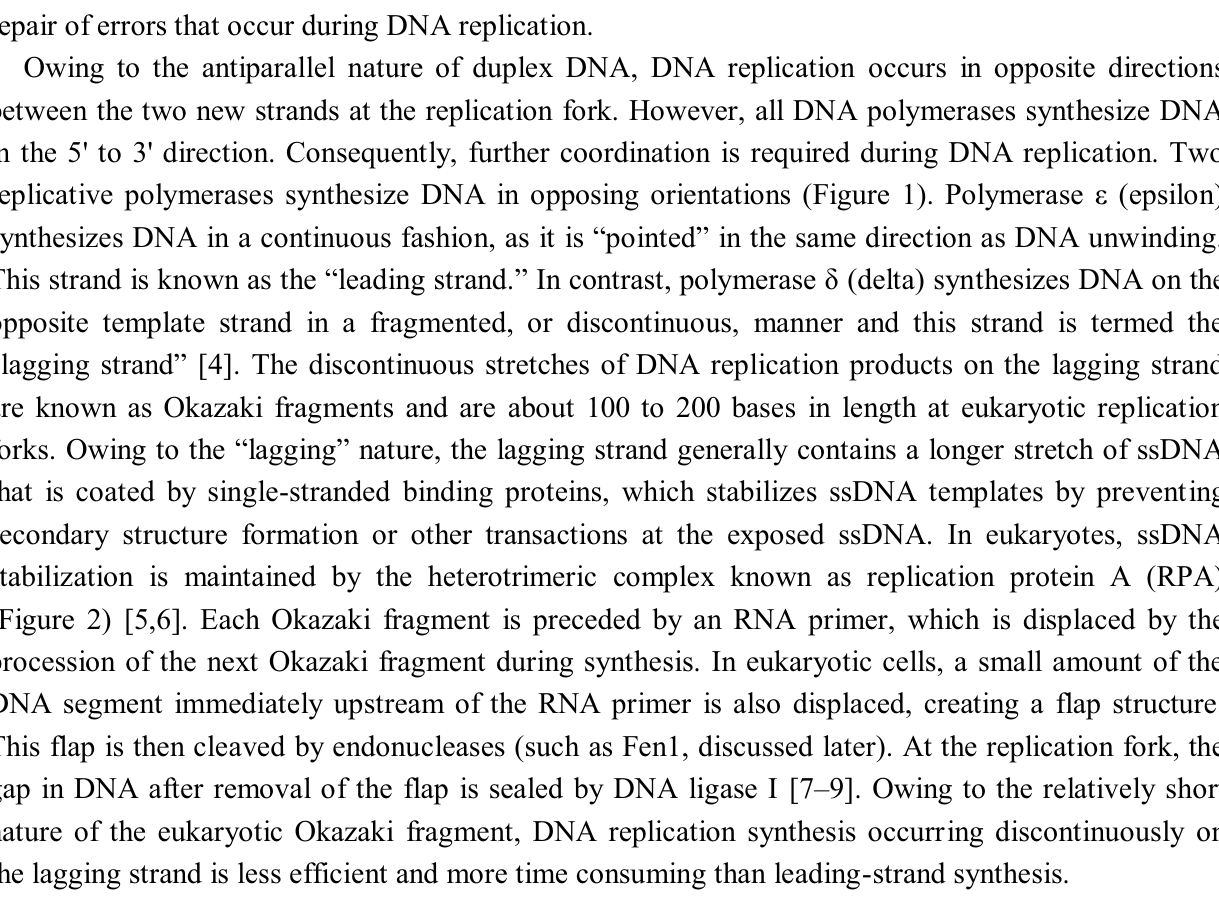
Figure 2. The eukaryotic replisome complex coordinates DNA replication. Replication